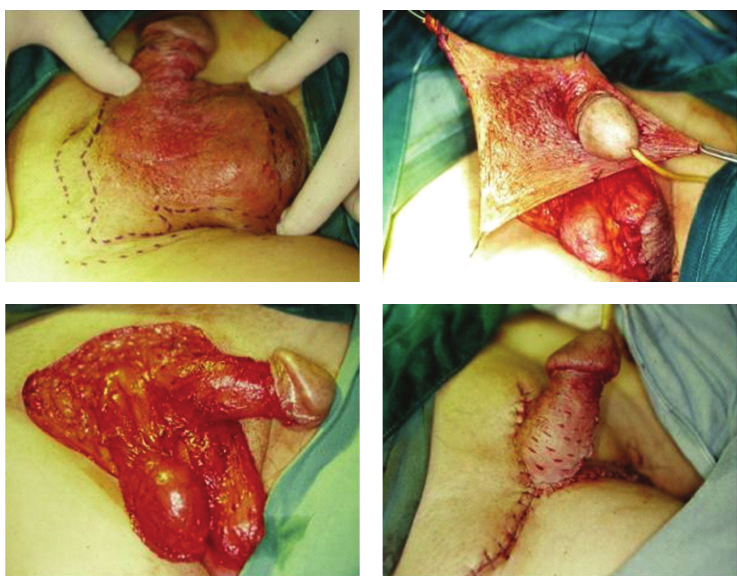
Figure 3: (Above, left) Large tumour involving penoscrotal region. (Above, right) Curative resection of the lesion required excision to the level of the corona of the glans penis. (Below, left) Resultant defect was too large for primary closure. (Below, right) Closure of the defect was achieved by mobilizing the upper thigh skin as well as partial thickness skin graft over the shaft of the penis.